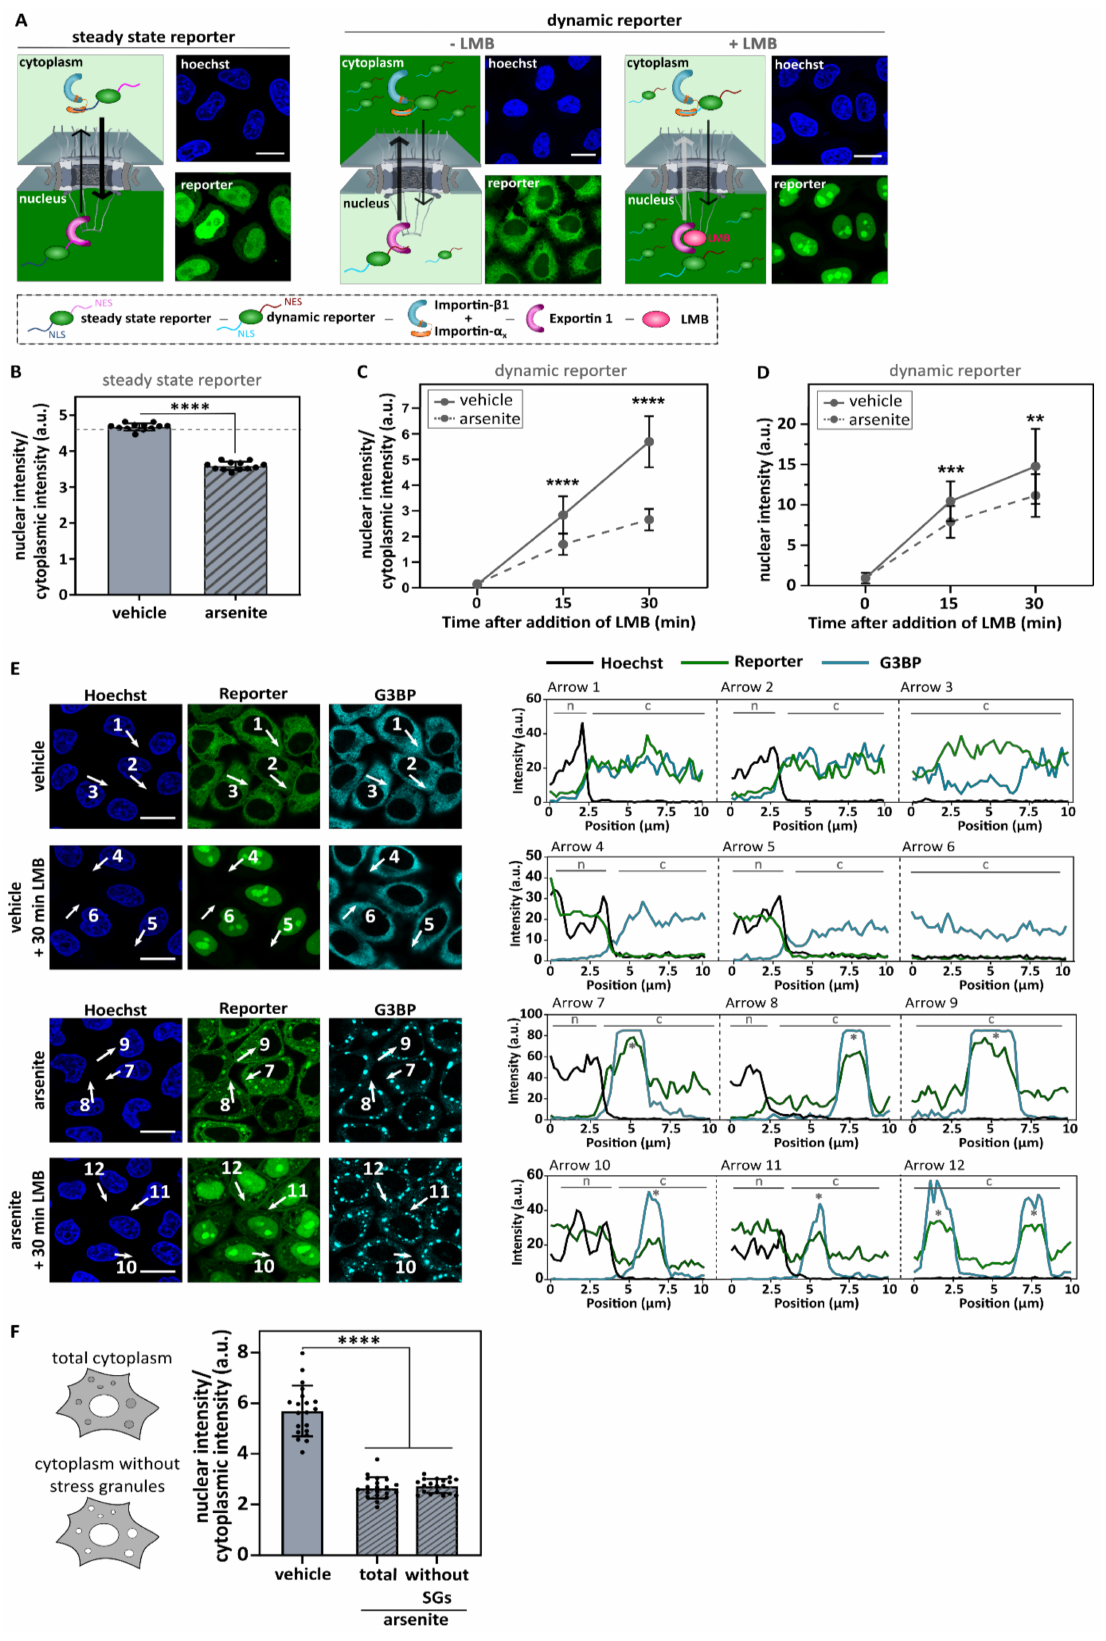
Figure 2. Sodium arsenite suppresses importin- β 1/ α 1-mediated import. ( A ). HeLa Kyoto cells sta- bly express the reporter construct NLS c-myc -GFP 2X -NES ikb2 (left) or the reporter construct NLS SV40